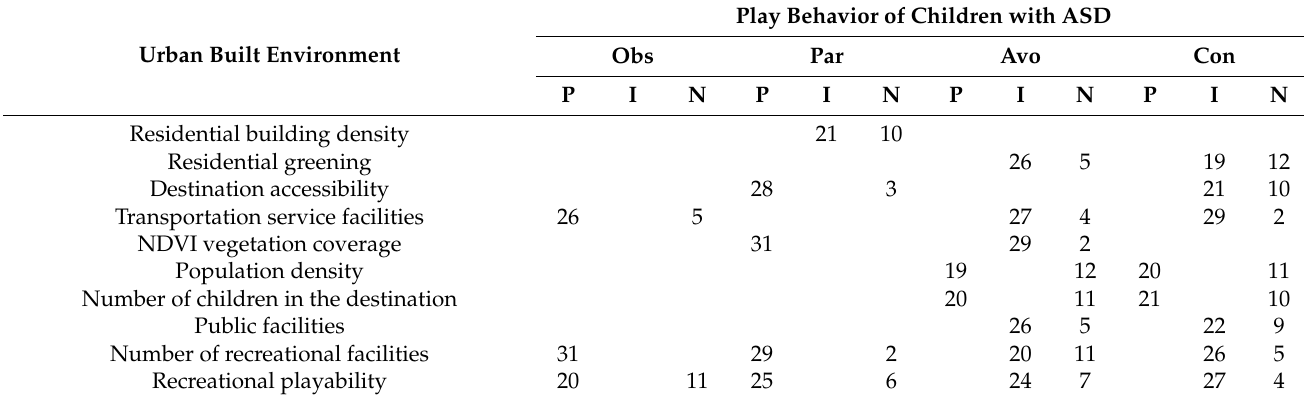
Table 8. Results of retrospective semi-structured